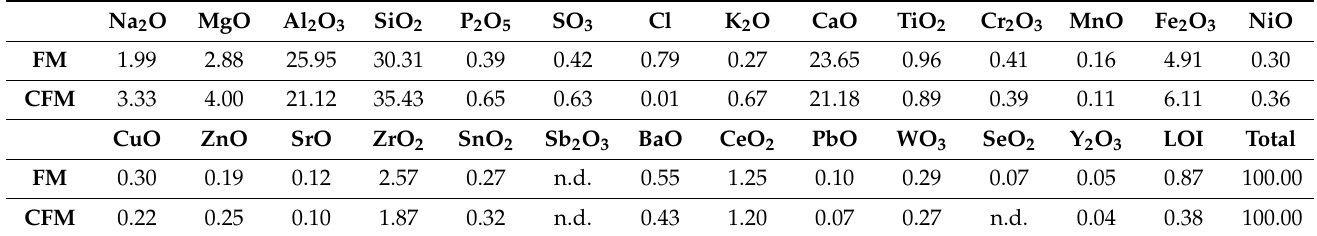
Table 1. XRF bulk data (expressed as oxides wt%) for the investigated flotation mud (FM) and related ceramic product (CFM); n.d. = not determined.